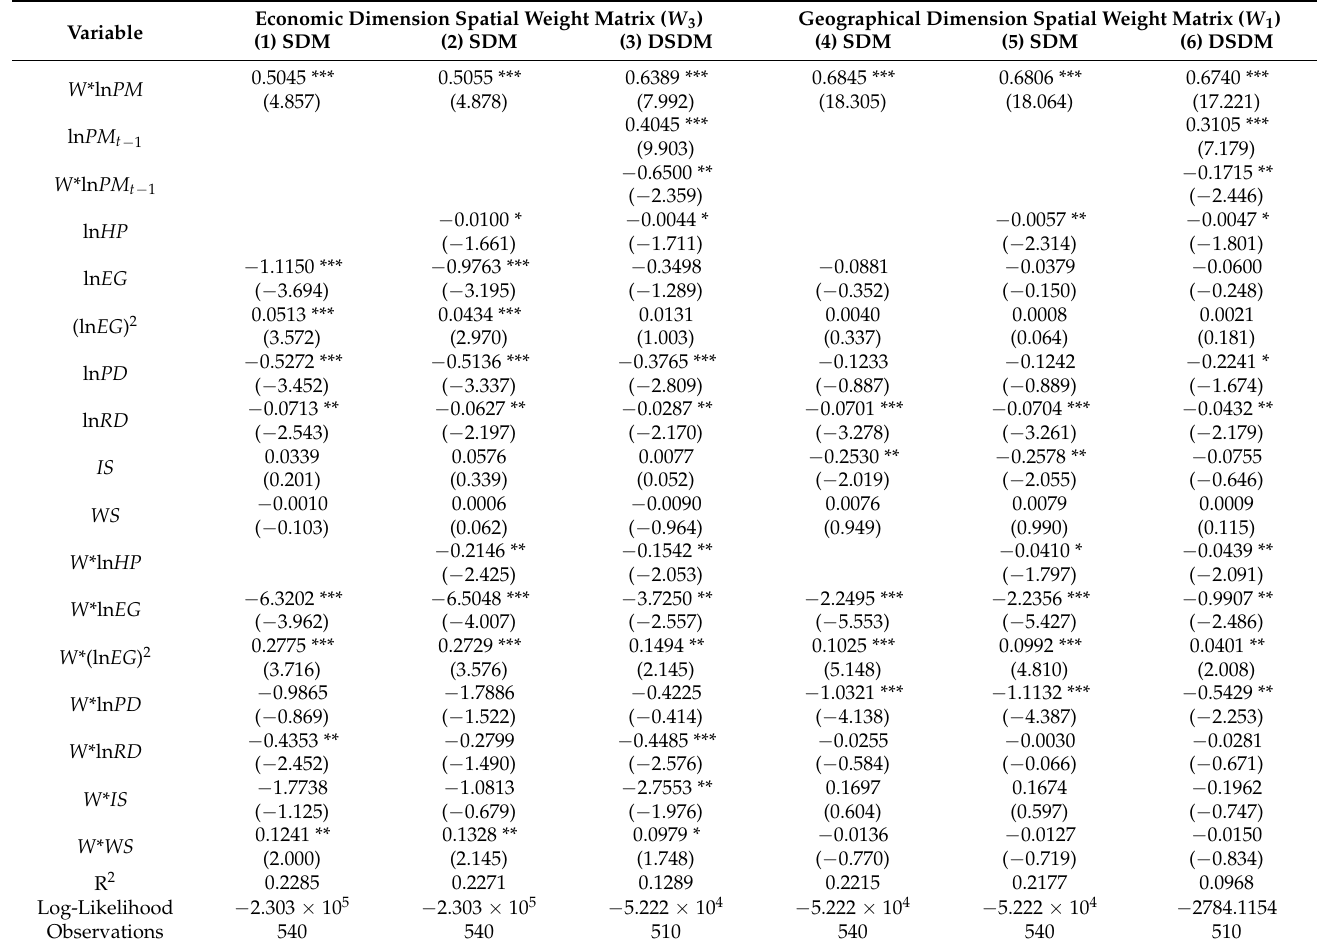
Table 6. Empirical results of the impact of hydropower on haze